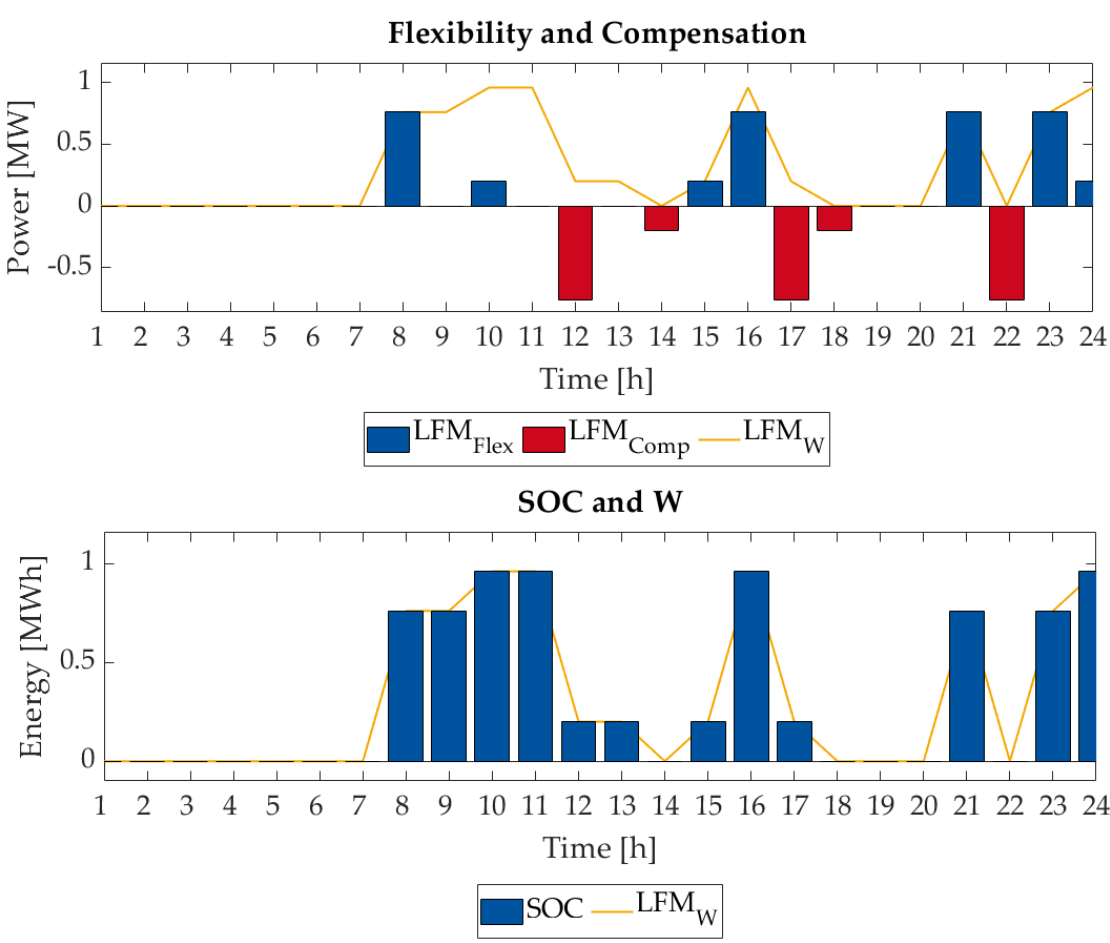
Figure A1. Bid variables and SOC for the SeqOpt mode of the 2–node case.